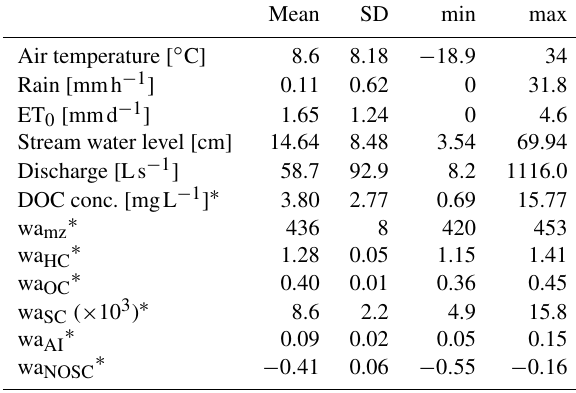
Table 1. Summary statistics of climatic, hydrological and chemical parameters of the study site and samples collected during the mon- itoring campaign between 12 April 2017 and 19 December 2018. ET 0 : potential evapotranspiration, and DOC conc.: DOC concen- tration. The symbol “wa” indicates peak-intensity-weighted aver- age values of the FT-ICR-MS-derived molecular parameters: wa mz (mass to charge ratio), wa HC (hydrogen to carbon ratio), wa OC (oxygen to carbon ratio), wa SC (sulfur to carbon ratio), wa AI (aro- maticity index), and wa NOSC (nominal oxidation state of